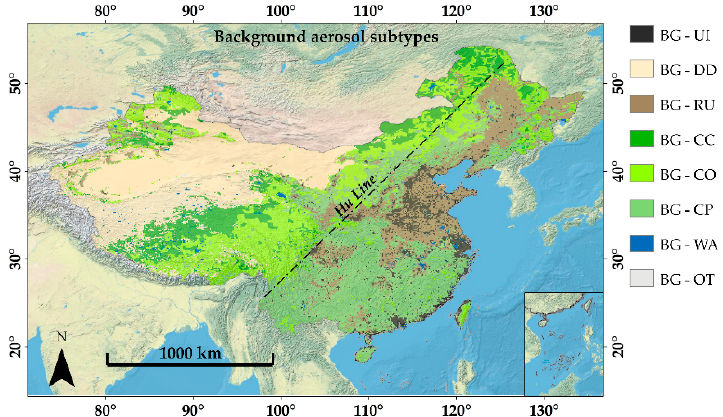
Figure 5. Spatial distribution of background aerosol subtypes over China. BG- UI, BG-DD, BG-RU, BG-CC, BG-CO, BG-CP, BG-WA, and BG-OT represent the background aerosol subtypes of